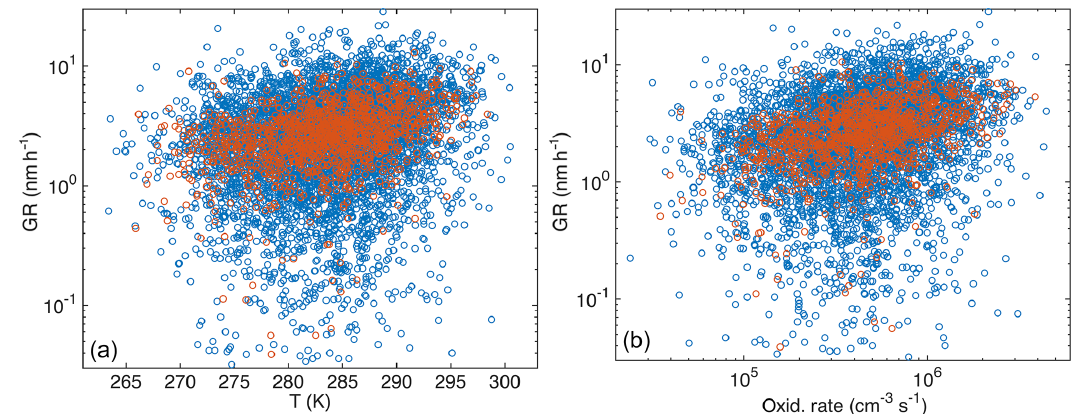
Figure 6. Particle growth rate (April–September, growth starts at d P <100nm) as a function of temperature (a) and oxidation rate of monoter- penes (b) . Blue circles are for growth period duration >2h and red for duration